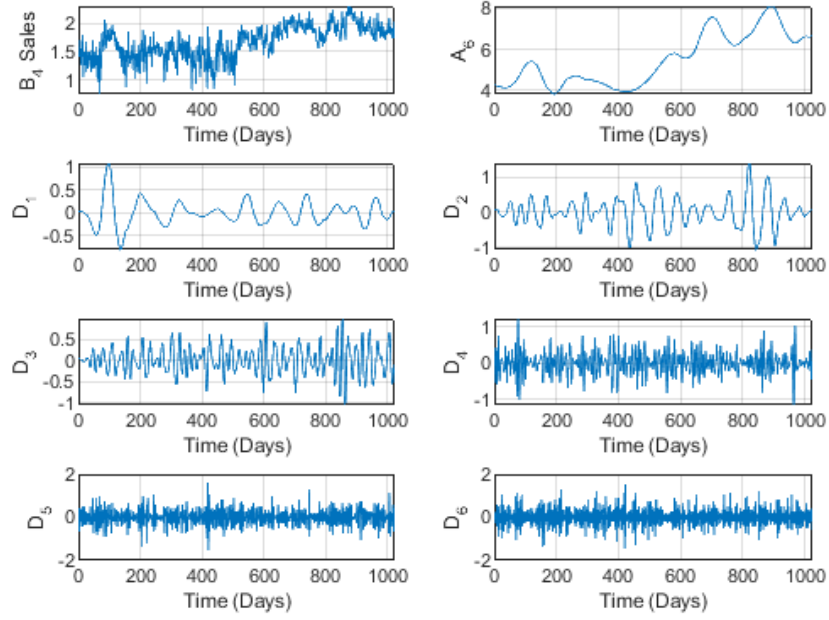
Figure 8. The wavelet decomposition of the Al Abdullatif brand B 4 sales at level